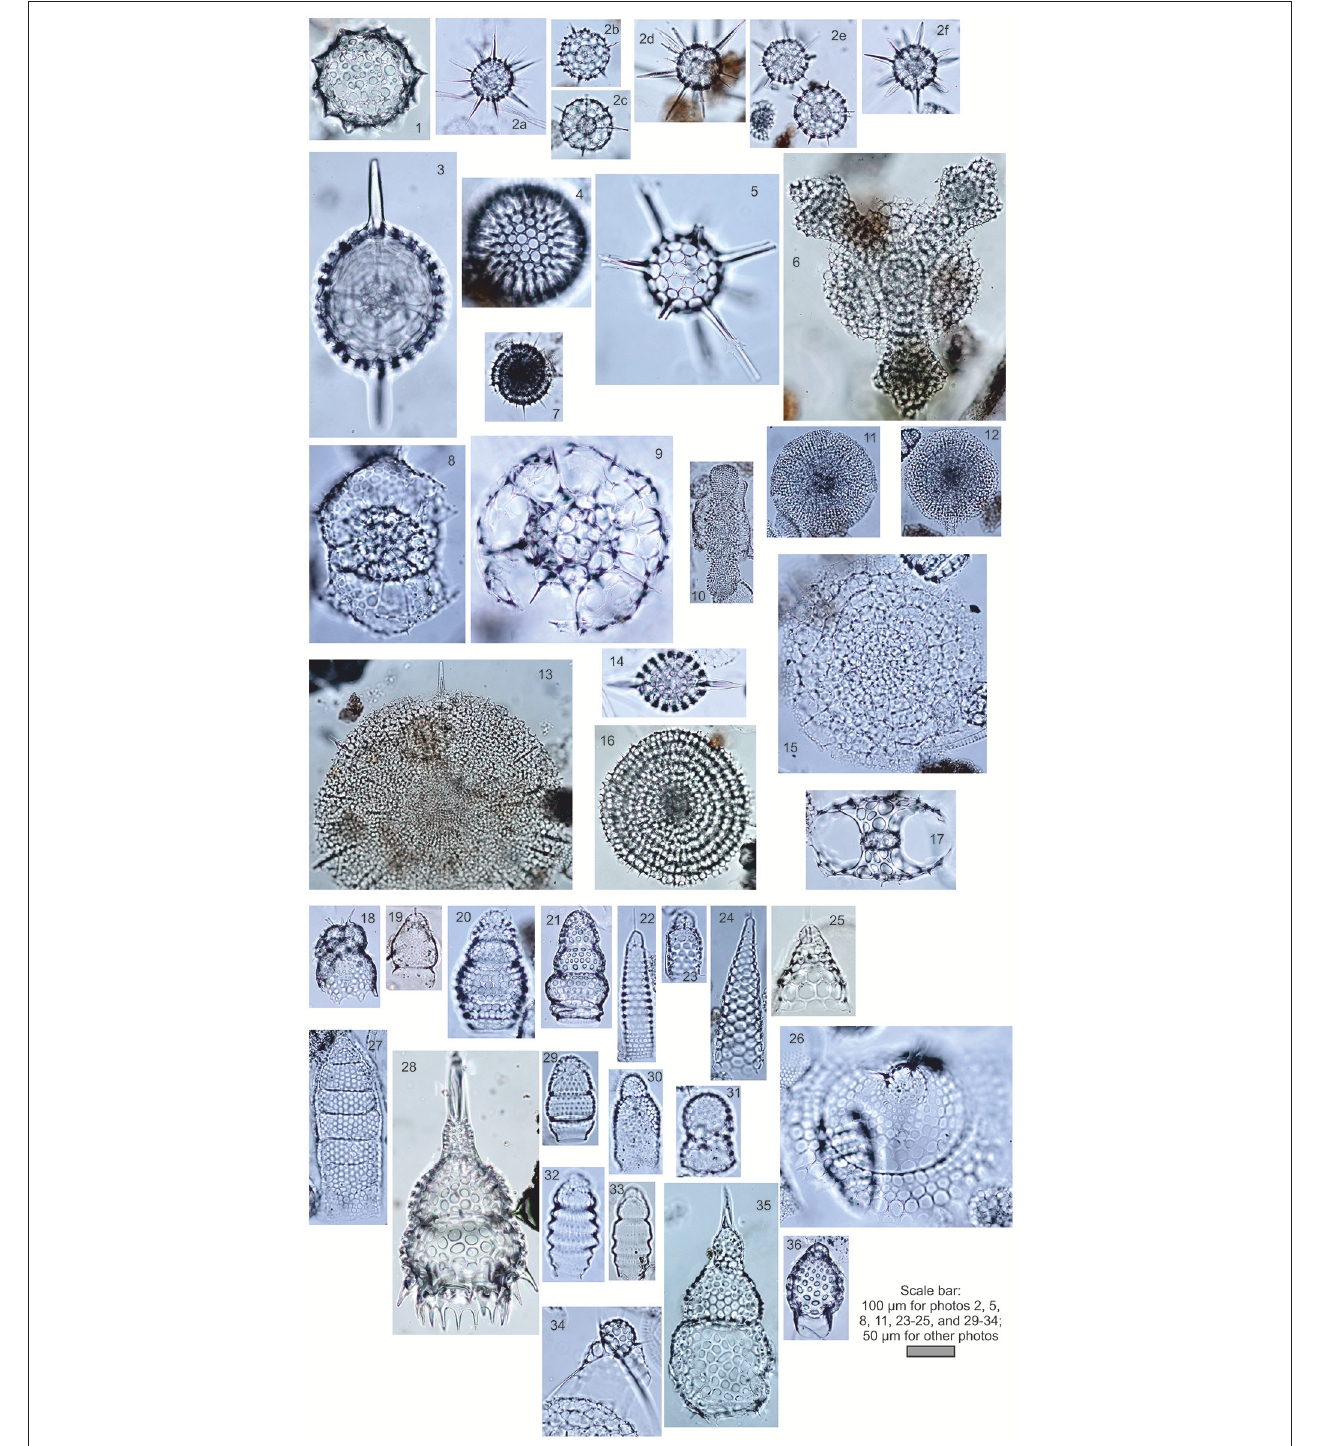
FIGURE 2 | Photos of radiolarians from the bottom surface sediments of the North Atlantic (number of photo, radiolarian name, station): Spumellaria, (1) Acrosphaera spinosa Haeckel, L-107; (2a-f) Actinomma boreale Cleve/A. leptodermum (Jørgensen) group, (2a) L-418, (2b-d) L-180, (2e-f) L-237; (3) Axoprunum stauraxonium Haeckel, L-90; (4) Cenosphaera favosa Haeckel, L-73; (5) Cleveiplegma boreale (Cleve), L-73; (6) Hymeniastrum euclidis Haeckel, L-107; (7) Lithelius spiralis Haeckel, L-237; (8) Phorticium clevei (Jørgensen), L-237; (9) Rhizosphaera medianum (Nigrini), L-73; (10) Spongocore puella Haeckel, L-73; (11) Spongodiscus resurgens Ehrenberg, L-73; (12) Spongopyle osculosa Dreyer, L-73; (13) Spongotrochus glacialis Popofsky, L-73; (14) Stylatractus pyriformis (Bailey), L-73;